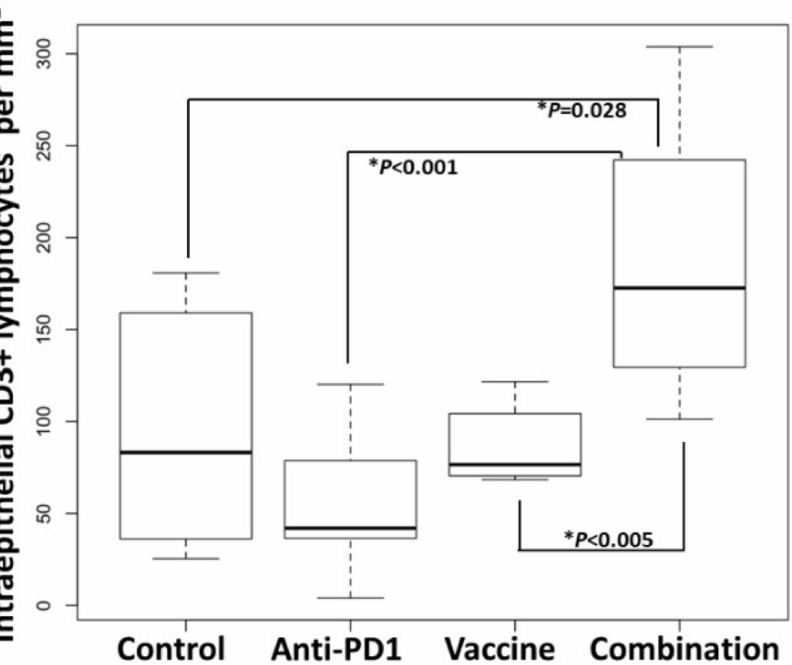
Figure 6. Combination of KISIMA-Mash2 vaccine and anti-PD-1 treatment results in higher T cell infiltration in Apc +/Min-FCCC mice. Anti-CD3 staining of adenomas from mice treated with buffer (Buffer), anti-PD1 alone ‘anti-PD1), KISIMA-Mash2 vaccine alone (Vaccine), or the KISIMA-Mash2 vaccine and anti-PD-1 combination (Combination). Box plots indicate the number of intraepithelial CD3+ lymphocytes per area (mm 2 ) of dysplasia in each animal. Kruskal-Wallis test comparing all 4 groups simultaneously p = 0.002. p values from two-sided Wilcoxon tests are shown on the